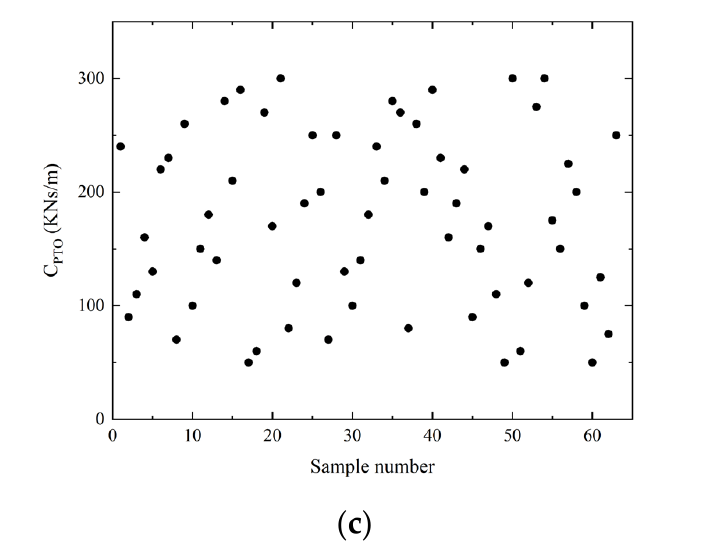
Energies 2022 , 15 , x FOR PEER REVIEW Figure 6. Sample scatter diagrams. ( a ) radius. ( b ) the ratio of draft radius. ( c ) C PTO . According to the sample points parameters, the simulation models are established. The wave excitation force, additional mass and radiation damping are calculated for each sample point based on ANSYS-AQWA. According to Equation (17), the mean annual power of each sample point was calculated, and the scatter diagrams are shown in Figure 7.